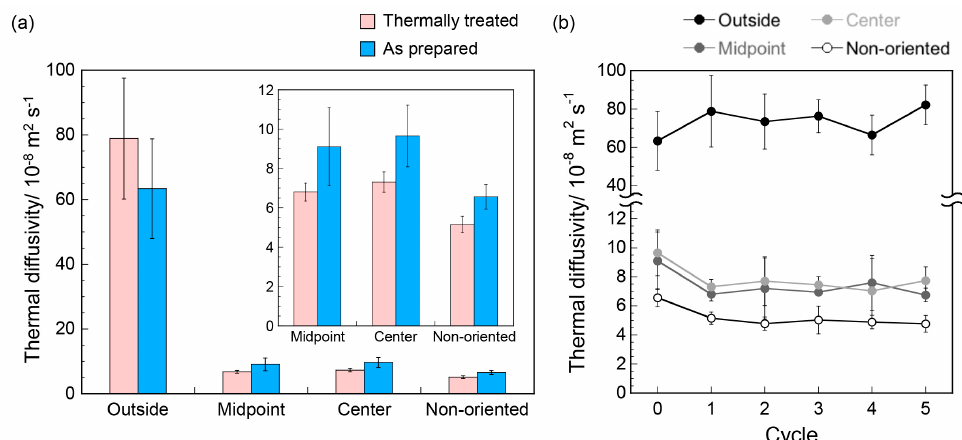
Figure 2. ( a ) Comparison of thermal diffusivity values of the as prepared and thermally treated M13 phage films. Thermal diffusivity values of the as prepared films were taken from ref. 34. Pink and blue bars represent thermal diffusivity values of the thermally treated and the as-prepared M13 phage films. Inset represents expanded view for the midpoint, center, and non-oriented M13 phage films. ( b ) Cyclic testing of thermal diffusivity of the films against thermal treatment. Thermal treatments and thermal diffusivity measurements were repeated for 5 times.